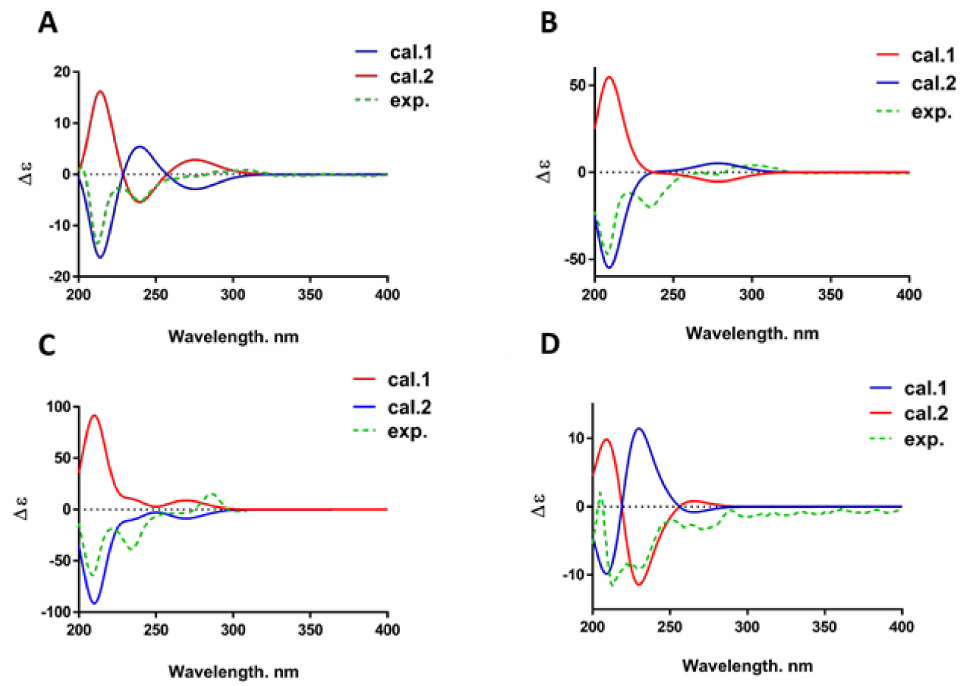
Figure 2. The ECD spectrum of compounds 2 , 4 , 14 , and 15 ( A – D